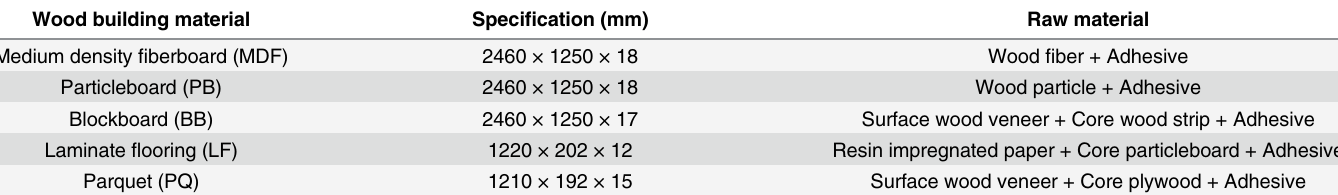
Table 1. Wood Building Materials for Formaldehyde Emission Tests of This Research.